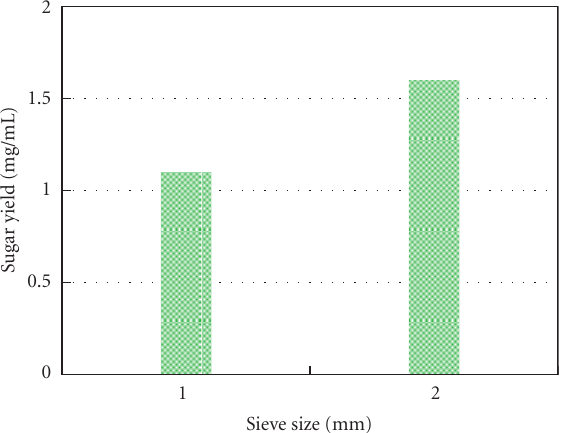
Figure 13: E ff ects of sieve size on sugar yield reported by Zhang et al. [30].